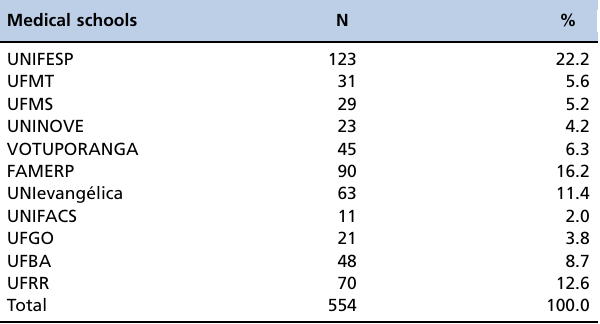
Table 2 - Distribution of the medical students group by institution.